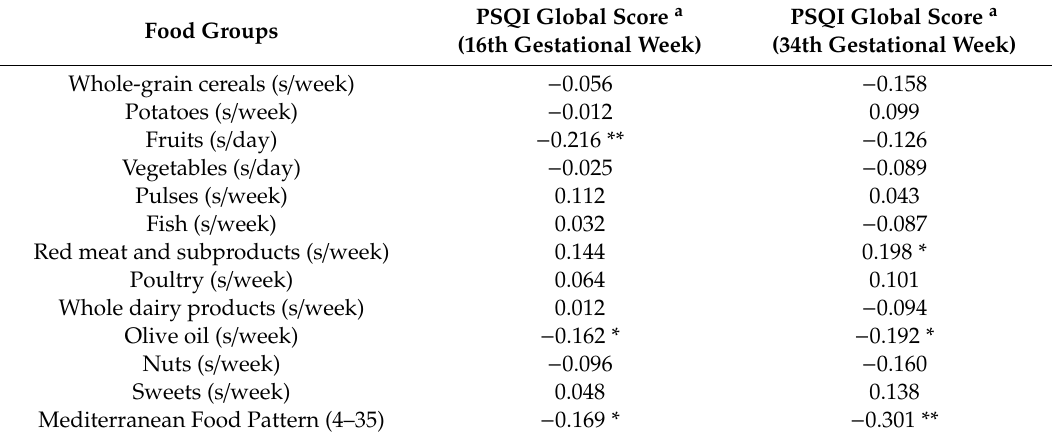
Table 2. Association between the Mediterranean Food Pattern and the Mediterranean diet components with the Pittsburgh Sleep Quality Index global score at the 16th gestational week ( n = 150) and 34th gestational week ( n =